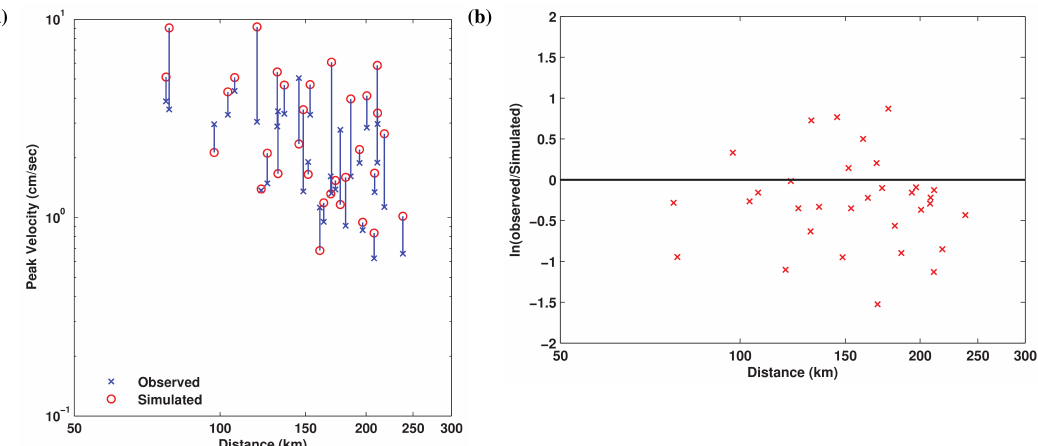
Figure 9. ( a ) Comparisons of peak ground velocity (PGV) of the simulated and the recorded broadband ground motions as a function of station distance to the hypocenter of the 1999 Hector Mine earthquake. ( b ) Natural log of the residual of simulated and recorded values.